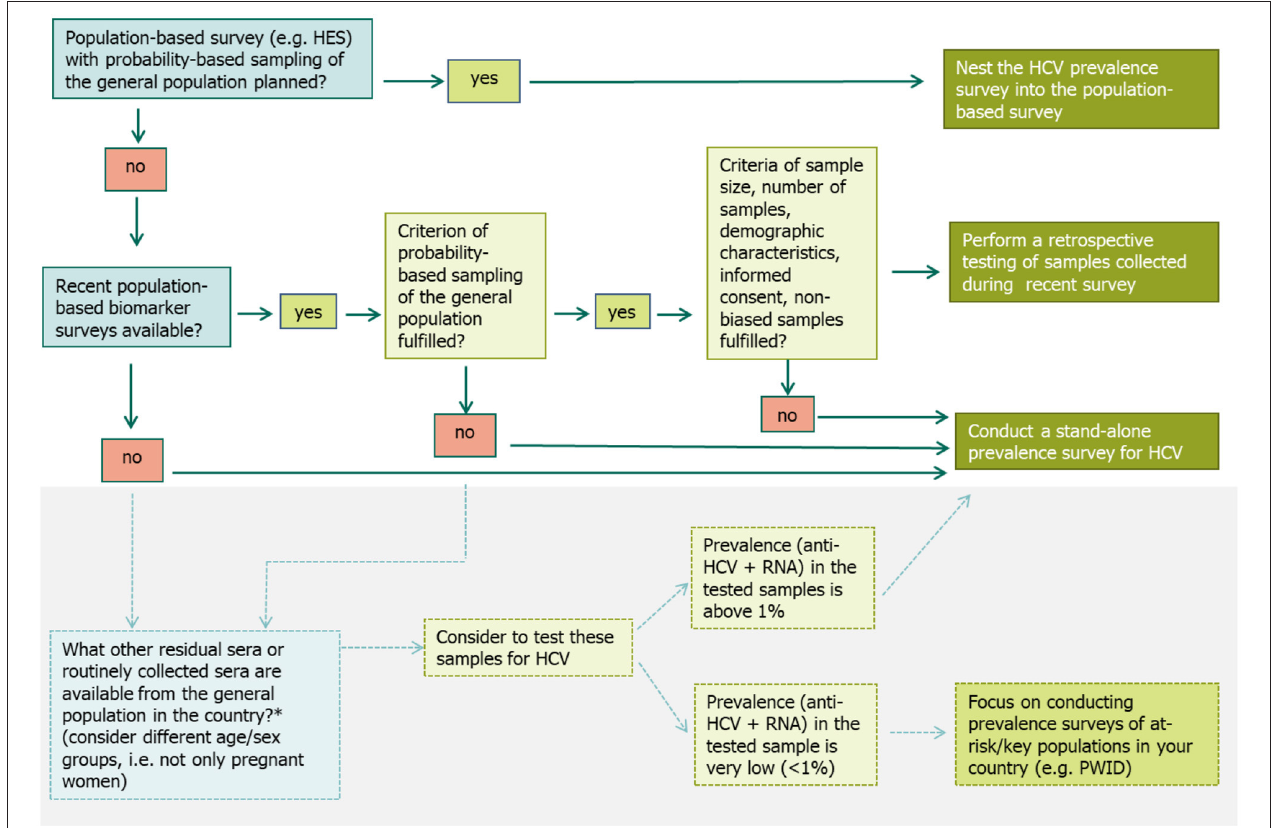
FIGURE 2 | Decision algorithm to select the most suitable survey approach when planning a prevalence survey for hepatitis C in the general population (15). *Alternative options exist that might be explored by countries to get an idea of the HCV prevalence level in the general population, if they do not have data from a recent population-based prevalence survey or plans for a future survey and few resources for a stand-alone survey (15).